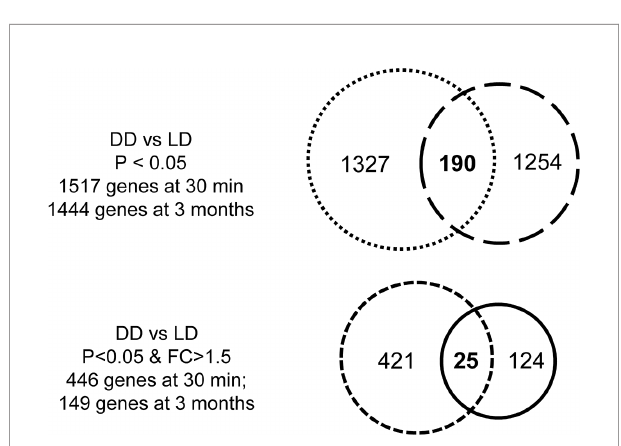
FIGURE 3 | Venn diagrams of DEGs. There were 1517 DEGs (DD vs LD) at 30 minutes and 1444 genes at 3 months when P < 0.05, with 190 genes in common over two time point, while the number of genes was reduced 446 or 149 at each respective time points when P < 0.05 and FC > 1.5, with only 25 genes in